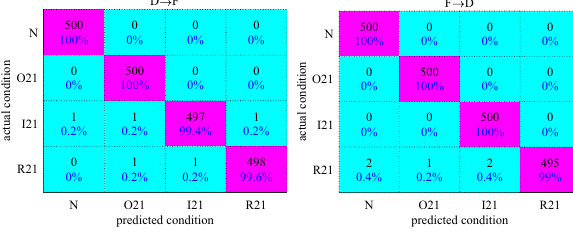
Figure 3. The experiment results of Task I (D → F and F → D).